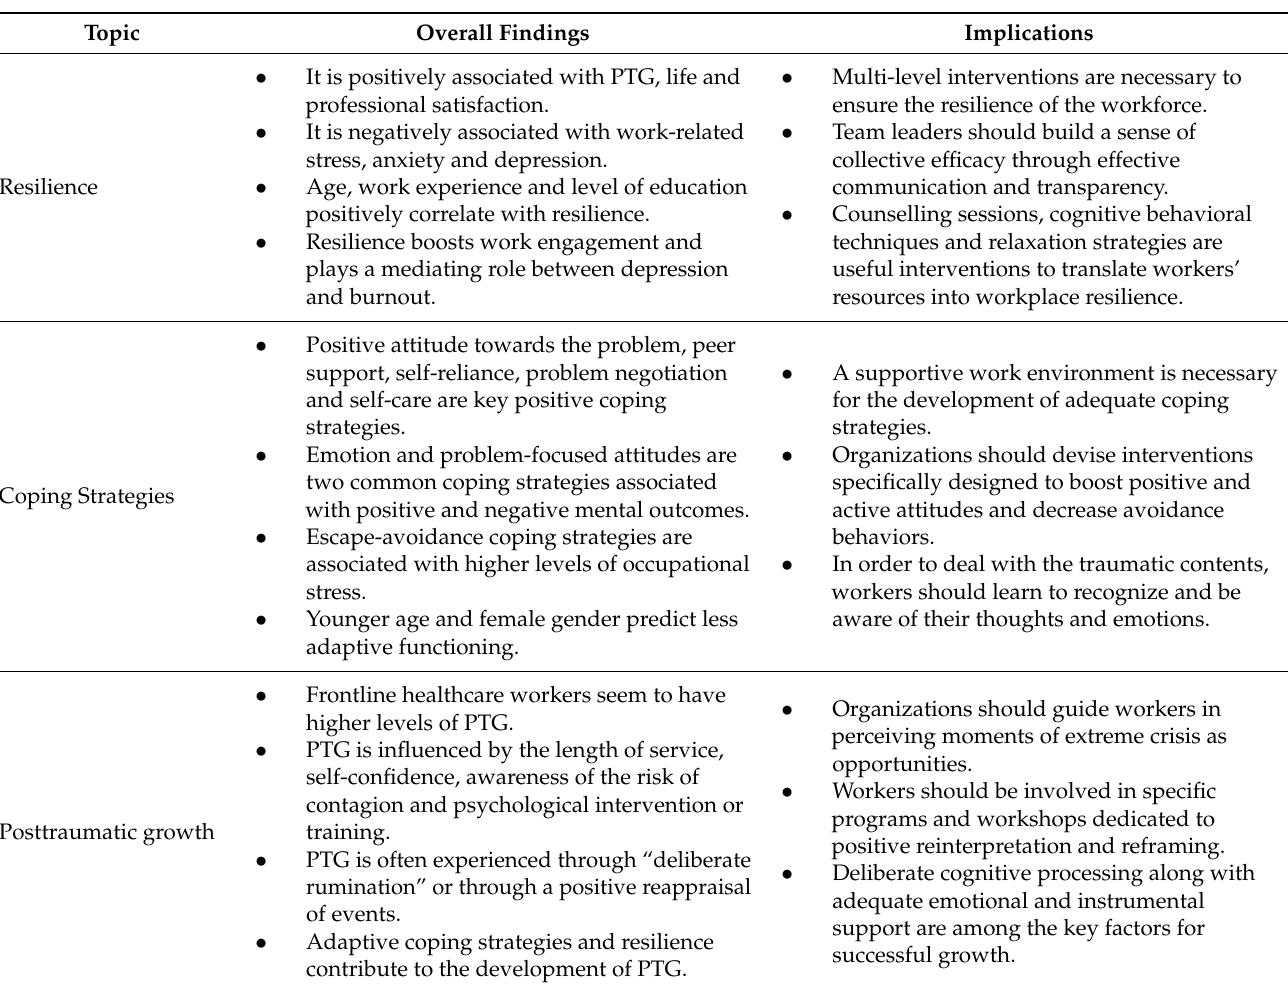
Table 2. Main findings and implications analyzed by